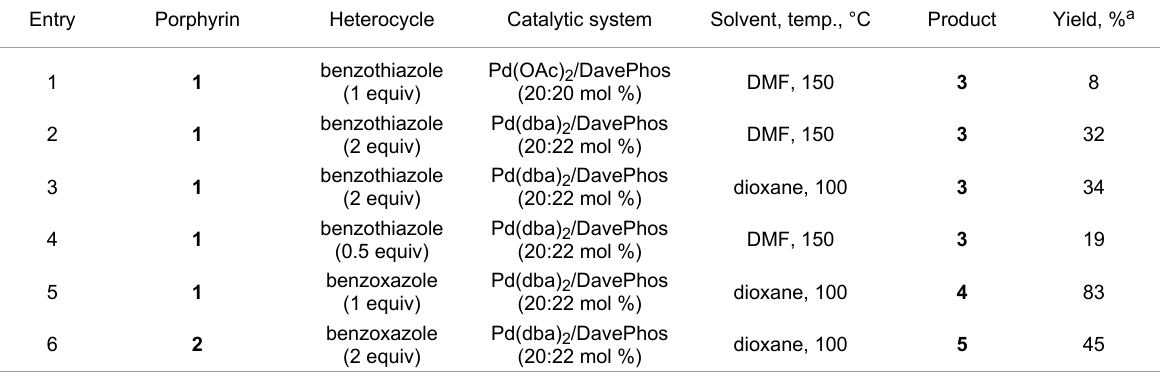
Table 1: Arylation of zinc meso -(bromophenyl)porphyrinates 1 , 2 with benzothiazole and benzoxazole (reaction time 24